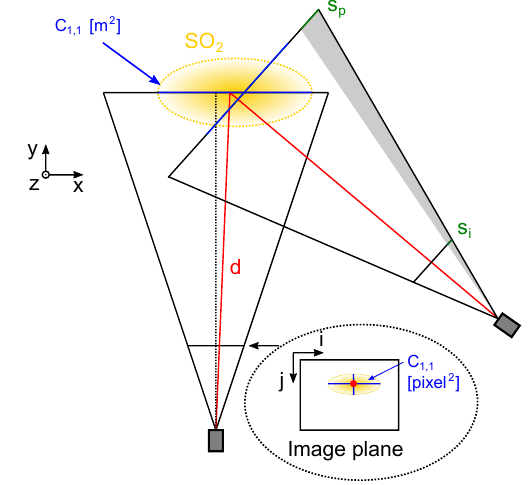
Figure 5. Sketch of the field of view of two cameras from above. The three-dimensional SO 2 puff (yellow) in the world coordinate system ( x,y,z ) is projected to the two-dimensional image plane ( i,j ). The centre of mass in the image plane corresponds to a solid angle in the world coordinate system (red). The apparent size of a pixel scales with the distance to the object plane (grey area).